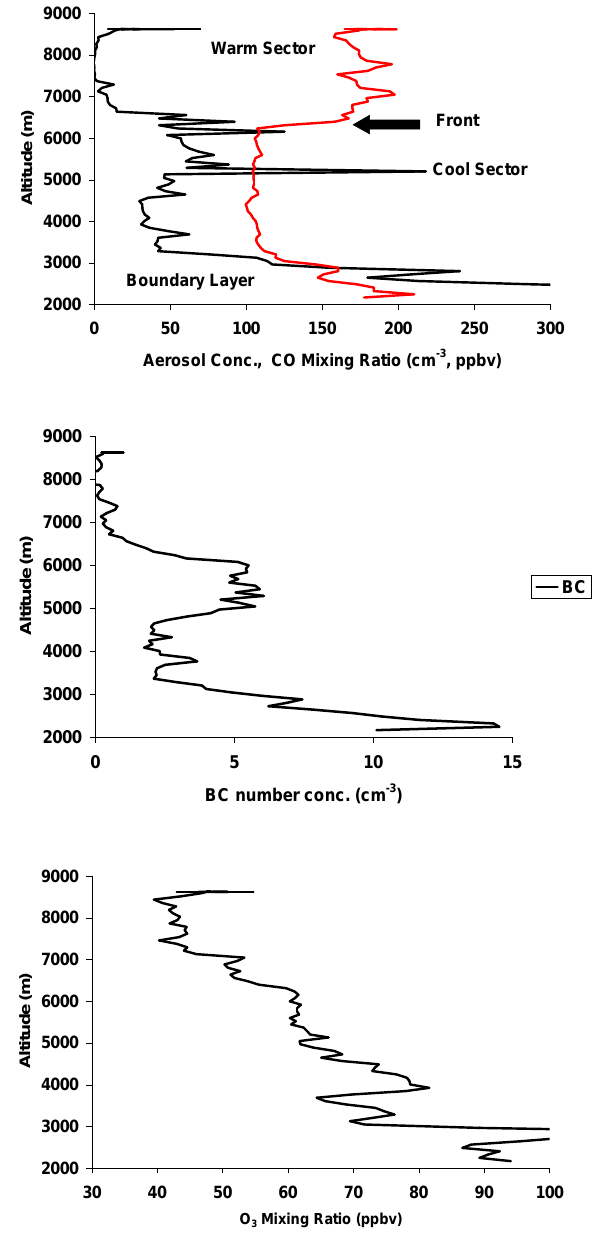
Fig. 2. Vertical profile through the warm frontal region in mostly clear air. Shown in the top figure are aerosol number concentration 0.1 to 1.0µm in size (black line) and CO (red line). (The lower curve for aerosol is cutoff at 300cm − 3 , but was over 500cm − 3 at the bot- tom of the profile). Number concentration of rBC particles (middle figure) and ozone mixing ratio (lower figure). The location for the profile is indicated in the lower right hand dark track in Fig. 1. The location of the warm frontal surface aloft and the different airmass characteristics are indicated in the top